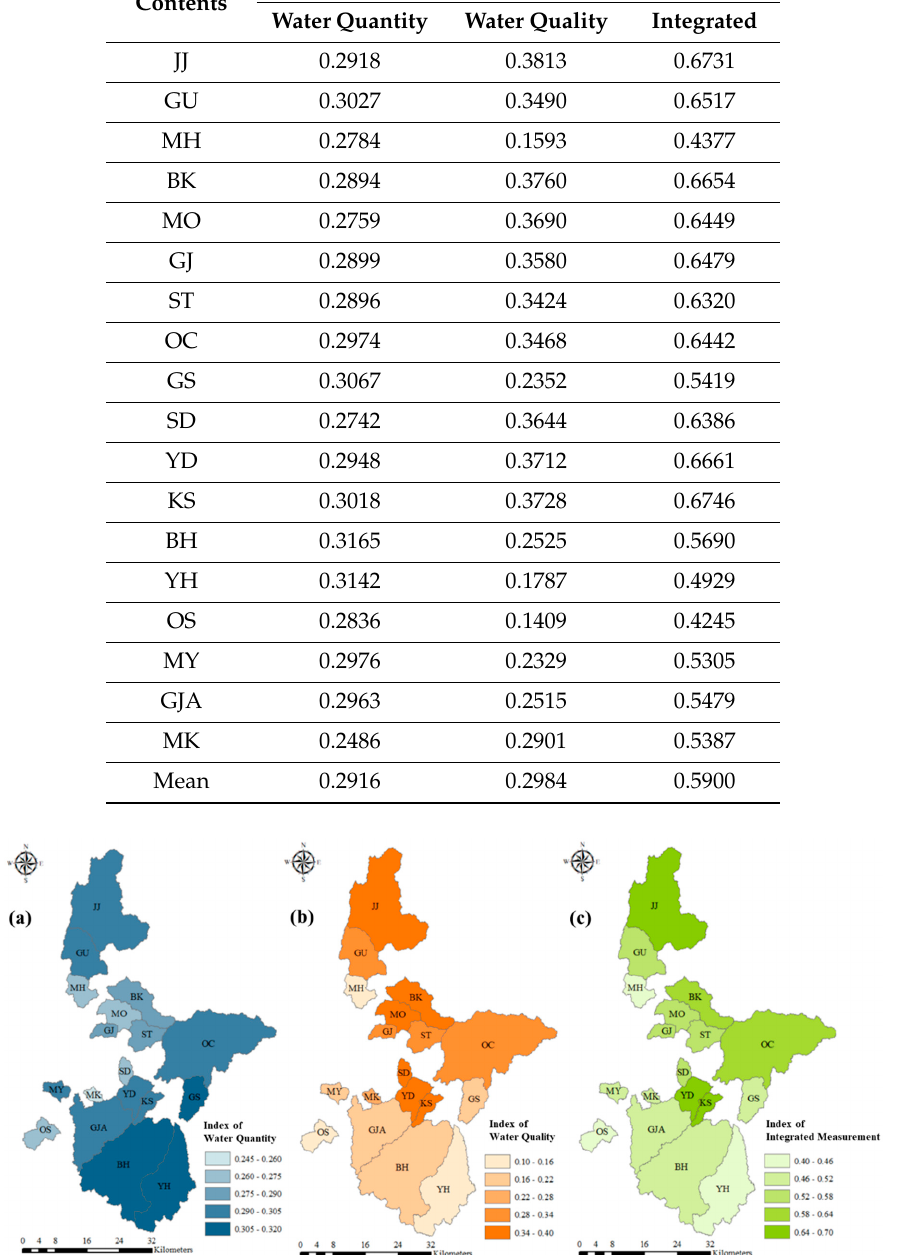
Figure 7. Spatial variation of mean indices during the study period. ( a ) Water amount index, ( b ) Water quality index, ( c ) Integrated measurement index.